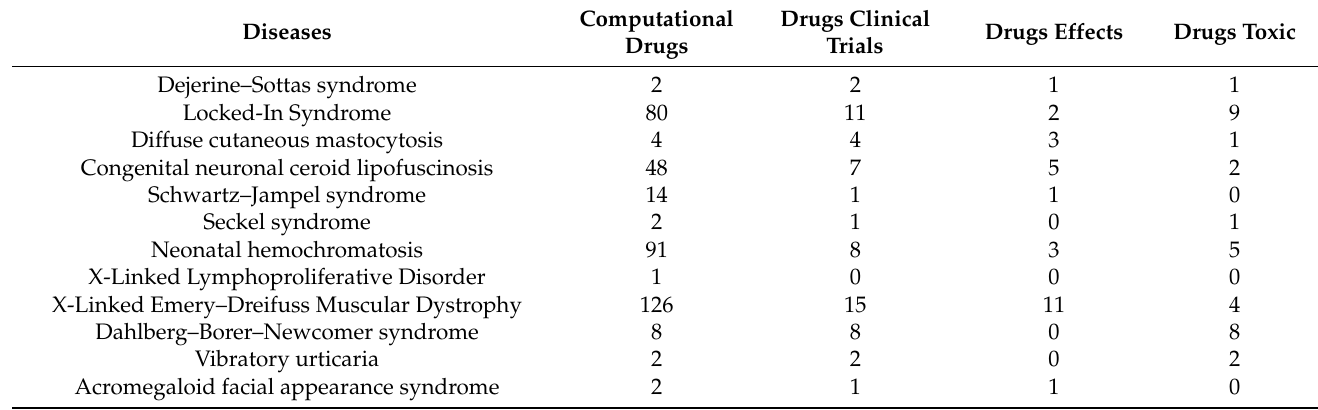
Table 3. Summary of the process to obtain the final number of potential drugs to treat the rare diseases under study. For each disease, the first column shows the number of drugs obtained through the approaches; the second column shows how many of these drugs have been found in the scientific literature; the third column is the number of drugs that can be used to treat the disease; and finally, the last column represents the number of toxic drugs that can produce the